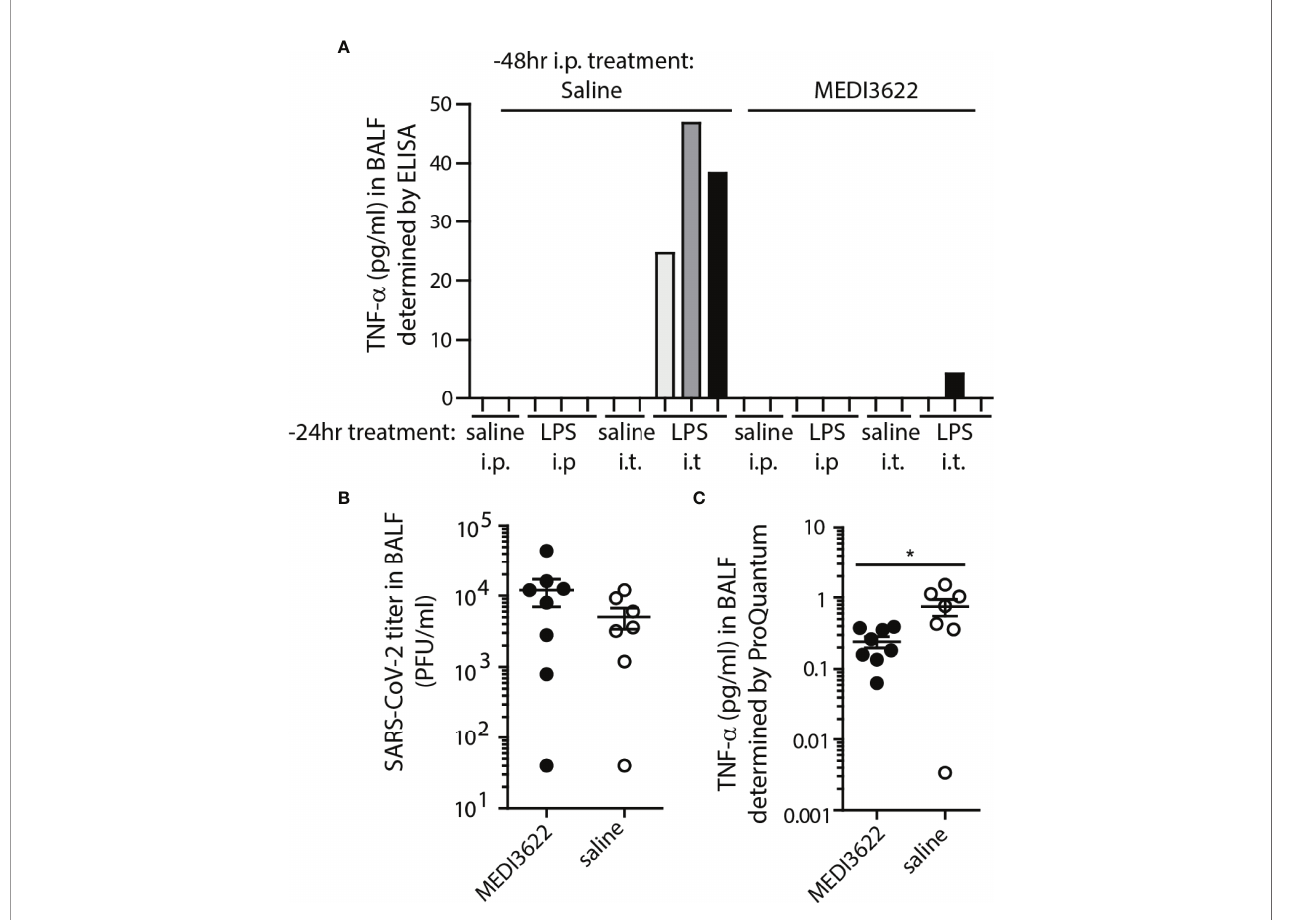
FIGURE 4 | MEDI3622 blocks soluble TNF- a production in the lung. (A) Mice were treated 48 hours prior to euthanasia with either saline or MEDI3622 by the i.p. route, then 24 hours later injected with either saline (2 mice per route) or 1ug/mouse E. coli LPS (3 mice per route) by either the i.p. or i.t. routes. Only those mice treated i.t. with LPS had TNF- a in BALF 24 hours after injection, and treatment with MEDI3622 blocked this detection. This experiment was performed one time with 2 or 3 mice per group. (B) BALFs were collected on day 4 post-infection from SARS-CoV-2 infected, saline or MEDI3622-treated mice. Infectious viral burden in MEDI3622-treated mice was slightly increased at this interval. (C) BALF from mice treated with MEDI3622 had signi fi cantly less TNF- a compared to control mice. *p<0.05. This experiment was performed one time with 7 or 8 mice per